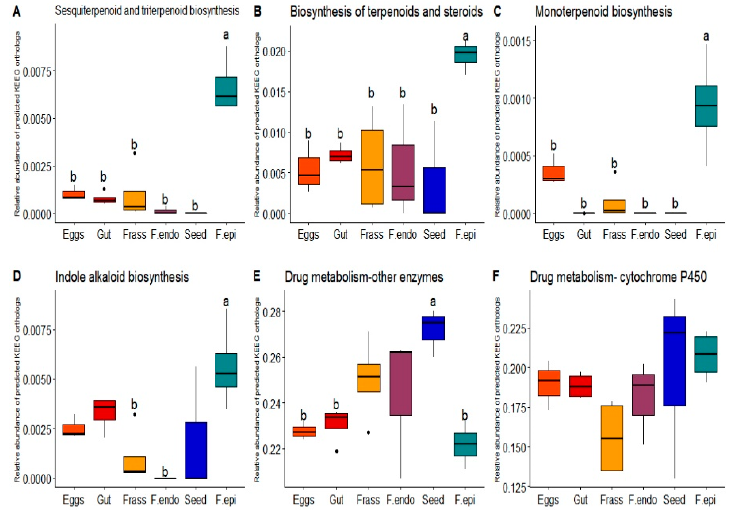
Figure 5. Relative abundances of KEGG orthologs (KOs) at level 1 involved drug metabolism of other enzymes, cytochrome p450, an indole alkaloid, sesquiterpenoid, and terpenoid, monoterpenoid biosynthesis, aminobenzoate degradation, geraniol degradation, and other glycan degradation inferred from samples of the plant D. inoxia and its specialist insect L. daturaphila . Different letters denote significant differences following a t-test ( P < 0.05).